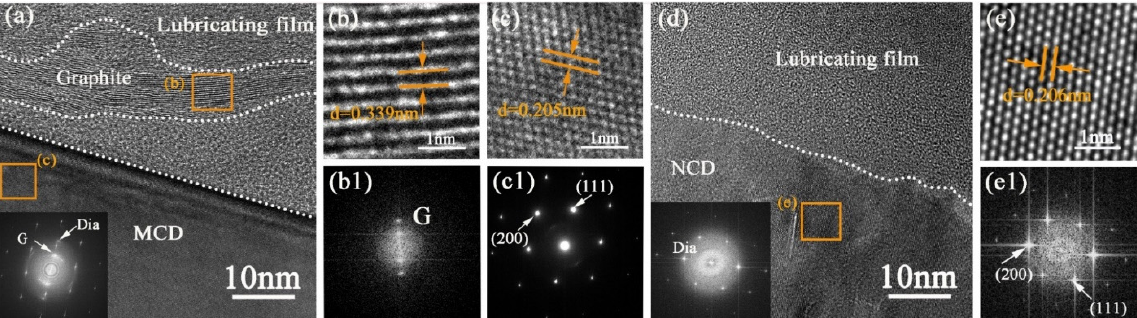
Figure 9. ( a ) The TEM image of the wear-scarred surface of the MCD coating; ( b ) HRTEM image of the graphite area of ( a ); ( b1 ) the FT diffractogram images of ( b ); ( c ) HRTEM image of the diamond area of ( a ); ( c1 ) the FT diffractogram images of ( c ); ( d ) The TEM image of the wear-scarred surface of the MCD coating; ( e ) HRTEM image of the diamond area of ( d ); ( e1 ) the FT diffractogram images of ( e ).